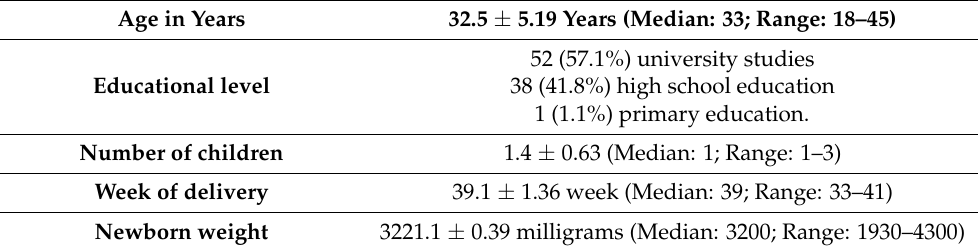
Table 1. Main characteristics of the